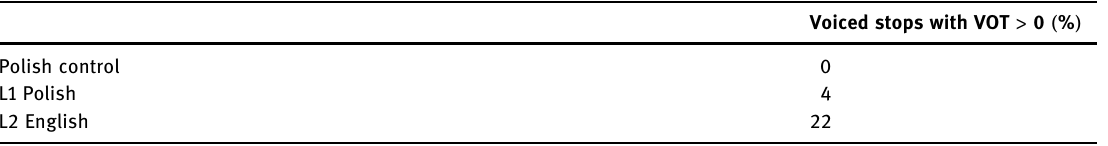
Voiced stops with VOT > 0 ( % )